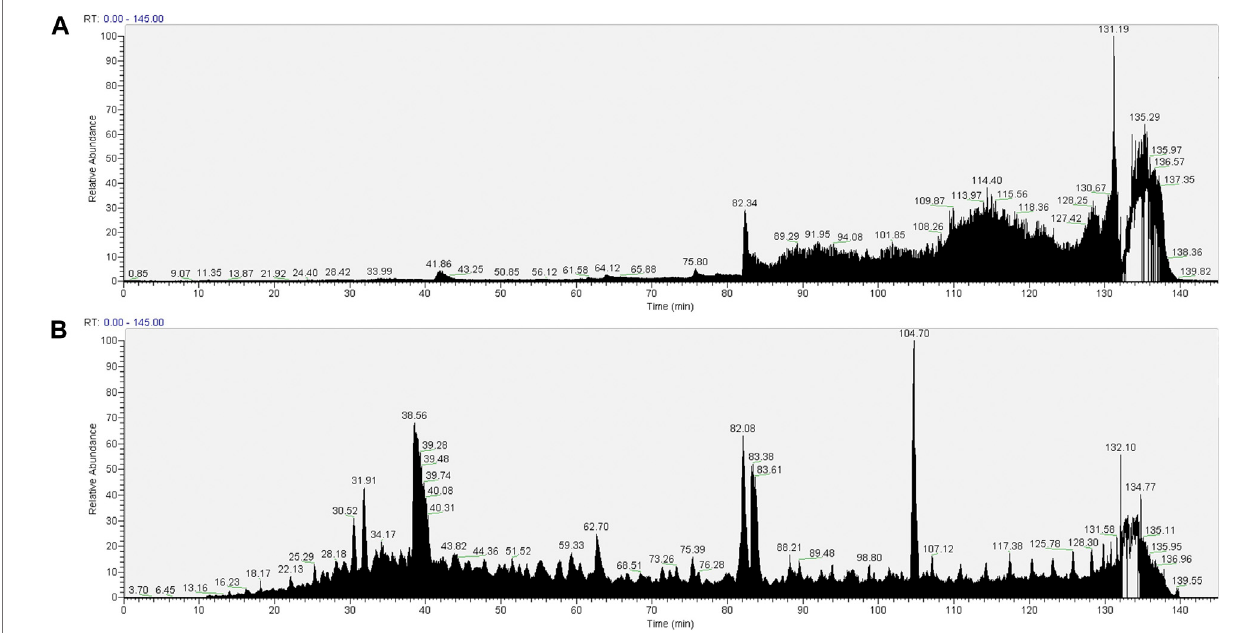
FIGURE4| TICofmaterialassociatedwithNeutrAvidinbeads followingwashprocedure 2(beadswerewashedwith2 × 1 mlofRIPA,2 × 1 mlofRIPA 1.2 MNaCl, and3 × PBS).Materialassociatedwithbeadsinthepull-downsfrom1.5%SMAsupernatants orRIPAsupernatants werereduced,alkylated,andthendigestedfromthe beads with trypsin (2.5 µg trypsin; 37 ° C, overnight). The resulting peptides were desalted using a SepPak cartridge. Peptides were fractionated on an Acclaim PepMap C18 reverse phase analytical column over a 150-min organic gradient, using seven gradient segments. TICs for (A) material in pull-downs from SMA-extracted supernatants and (B) material in pull-downs from RIPA-extracted supernatants are shown.